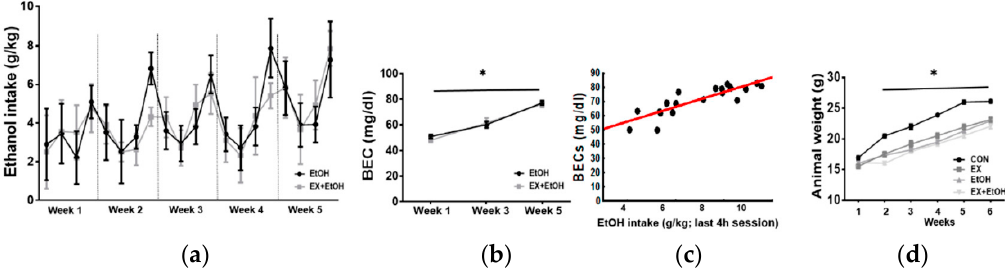
Figure2. ChangesinalcoholconsumptionandweightoftheanimalsduringDIDprotocol. ( a )Significant Figure 2. Changes in alcohol consumption and weight of the animals during DID protocol . ( a ) di ff erences were not found between groups, but significant e ff ects of the session ( p = 0.001) and week Significant differences were not found between groups, but significant effects of the session ( p = 0.001) ( p < 0.0001) were and week ( p < 0.0001) were observed. ( b ) BEC levels during the first, third, and fifth weeks and animal weight in the different experimental conditions. BECs in the EtOH and EX + EtOH groups are expressed as milligrams per deciliter (mg/dL). The quantity of alcohol in the blood increased over time ( p < 0.0001), but significant differences were not found between groups. ( c ) A significant correlation between BEC levels and EtOH intake in the last 4 h session was found ( p < 0.001). ( d ) Animal weight over time. All data are mean ± SEM.